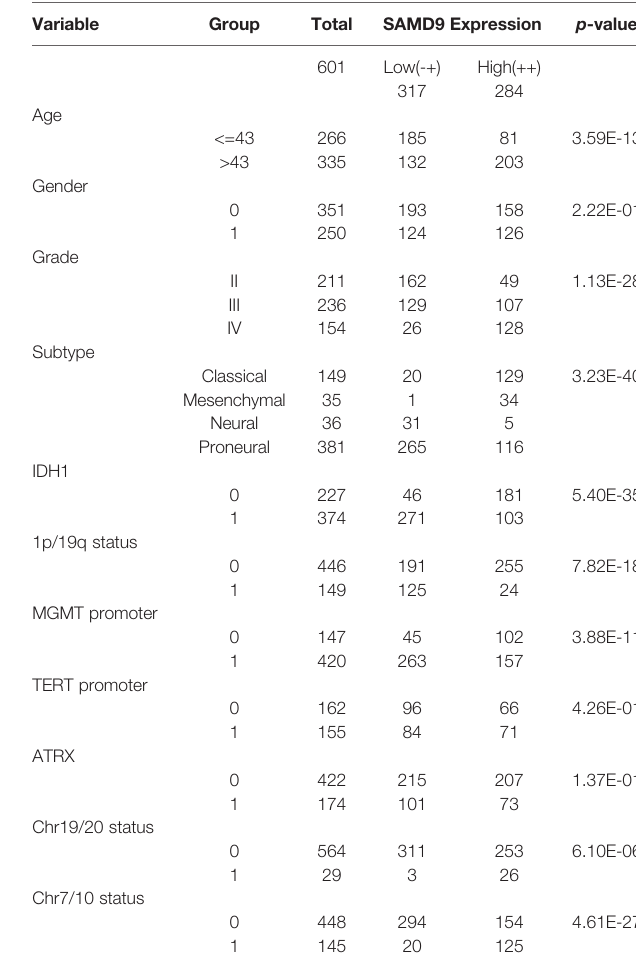
TABLE 2 | Clinicopathological of SAMD9 expression in TCGA